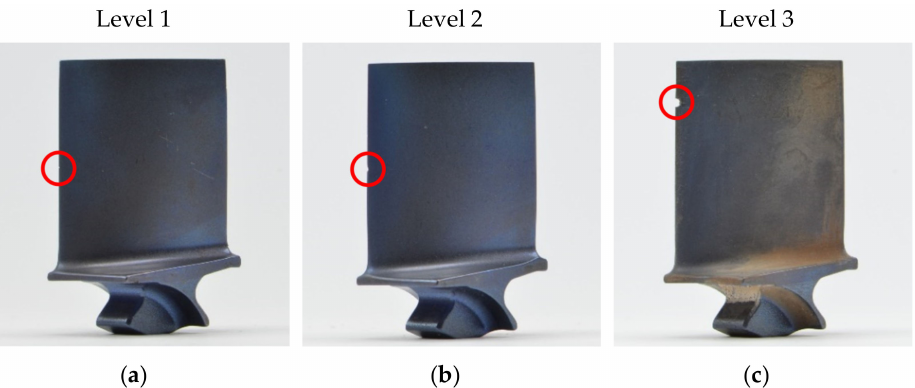
Figure 5. Different levels of defect severity from ( a ) lowest Level 1 to ( c ) highest Level 3. The defects are highlighted by red circles.